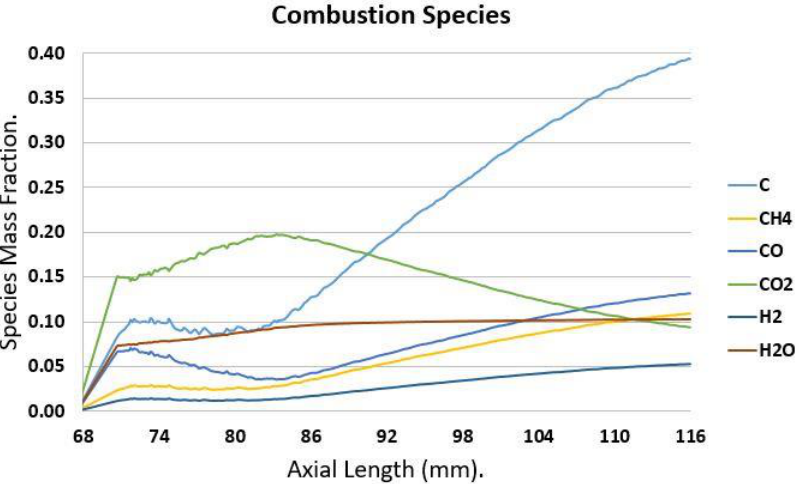
Figure 25. Mass fraction of combustion species obtained from CFD.